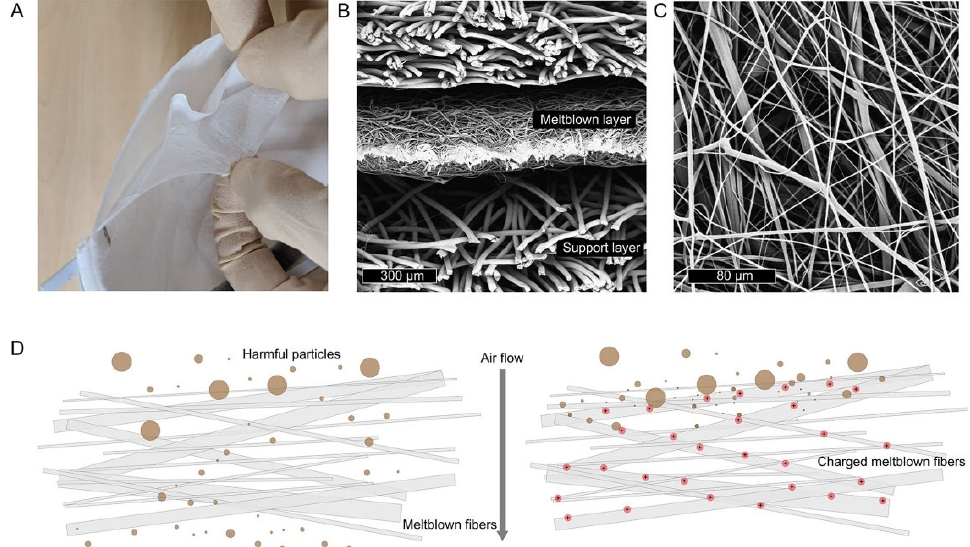
Figure 7. Meltblown fabrics in N95 FFRs. ( A ) Peeling apart a representative N95 FFR reveals multiple layers of nonwoven materials. ( B ) Scanning electron microscope (SEM) cross-section image reveals the middle meltblown layer has thinner fibers with thickness around 300 μ m. ( C ) SEM image of meltblown fibers reveals a complicated randomly oriented network of fibers, with diameters in the range of ∼ 1 − 10 μ m. ( D ) Schematic illustration of meltblown fibers (left) without and (right) with electret charging. In the left figure, smaller particles are able to pass through to the user, but particles are electrostatically captured in the case of an electret (right). Reprinted with permission from ref. [121] .